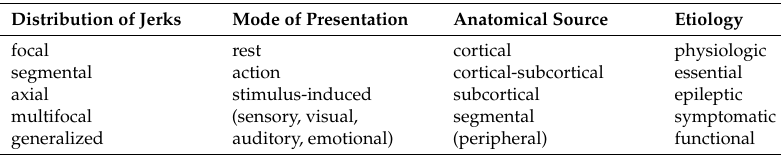
Table 1. Different approaches at the classification of